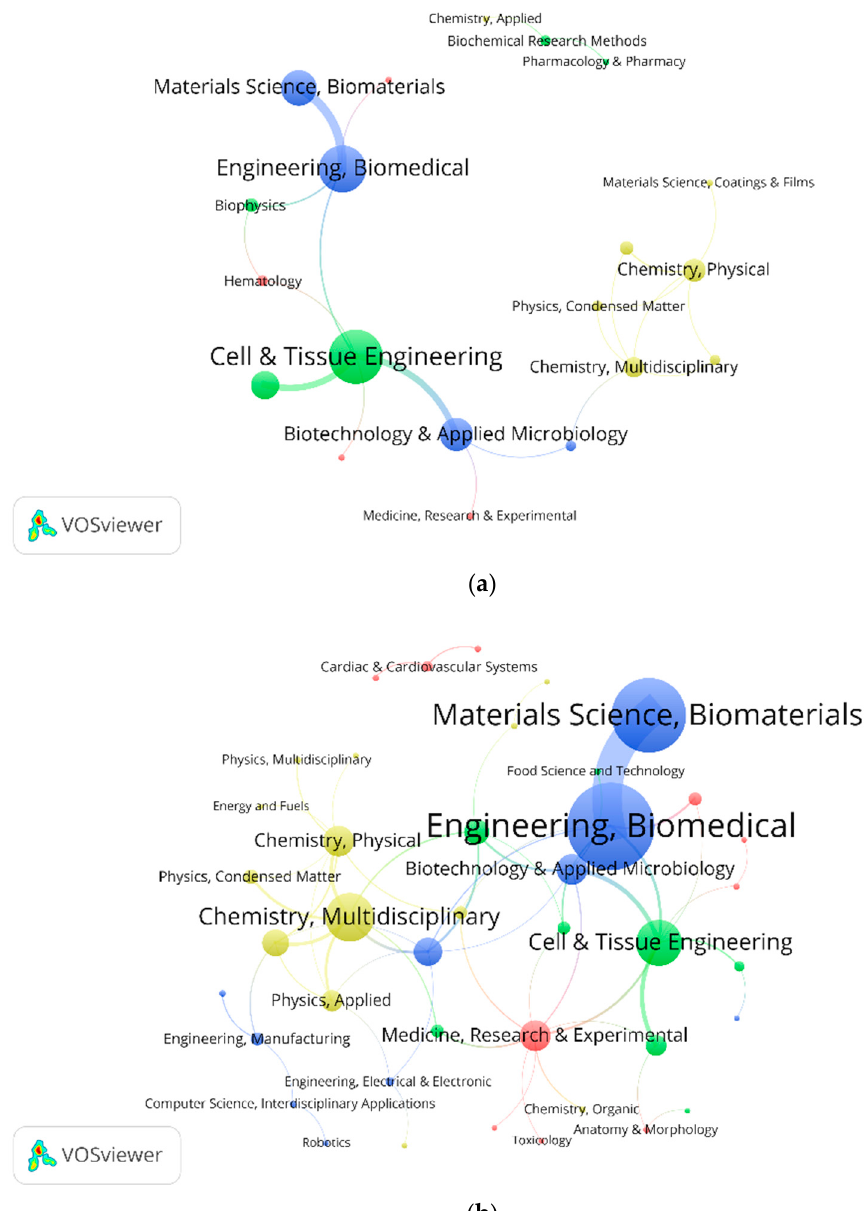
Figure 2. The science mapping of Web of ScienceTM (WoS) categories for assessing bioprinting evolution in time slices, ( a ): 2006–2010; ( b ): 2011–2015. The WoS categories were grouped into “macro-disciplines”: Matter Sciences (yellow), Engineering (blue), Biology (green), and Medicine (red). The size of each node is proportionate to its degree and the thickness of the links represents the tie strength.